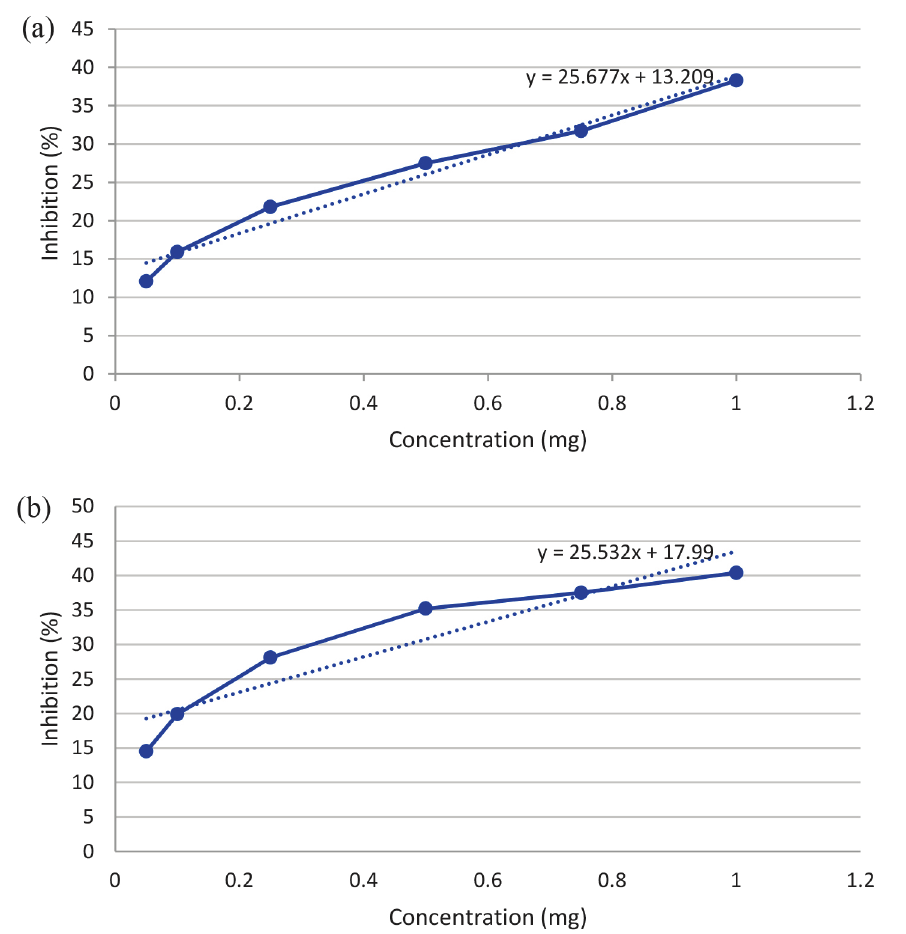
FIGURE 1 - DPPH radical scavenging activity; (a) essential oil extracted by HD method, (b) essential oil extracted by MAHD method. IC value for Ascorbic acid as control was obtained 0.06 50